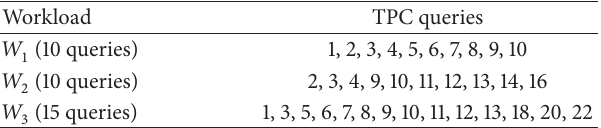
Table 8: TPC-H queries used in the workloads. Workload TPC